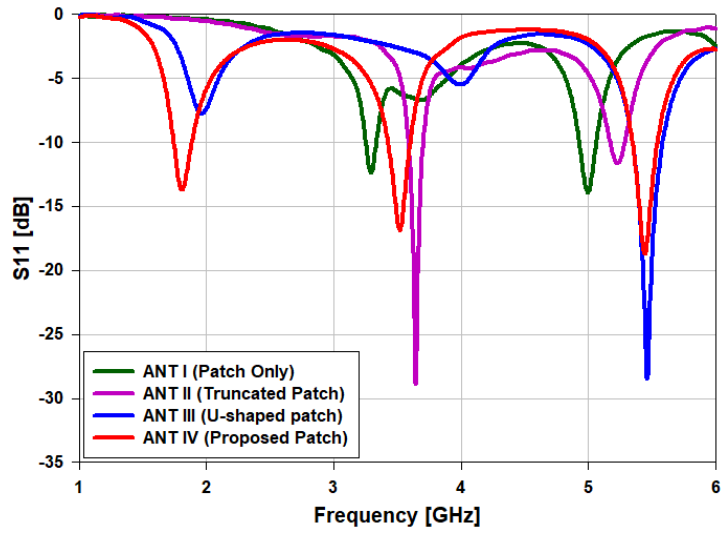
Figure 4. Simulated S 11 for the corresponding design steps.